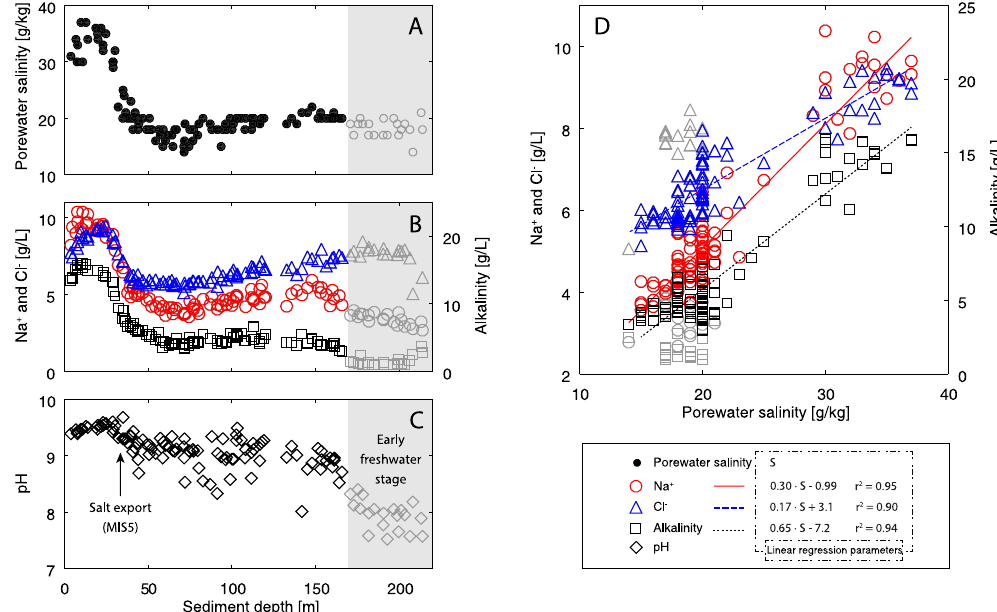
Figure 3. Salinity, Na + , Cl − , alkalinity, and pH profiles measured in the pore water of Lake Van. All measurements were conducted in the pore water of the same core-catcher samples used for the determination of salinity. The curves of the conservative species Na + (panel B, red circles) and Cl − (panel B, blue triangles), as well as that of alkalinity (panel B, black squares), mimic the shape of the salinity profile (panel A; see also Fig. 2). The linear correlations that exist between salinity and both Na + and Cl − (panel D, red circles/line and blue triangles/line) demonstrate that total salinity in Lake Van is virtually geochemically conservative and can thus be used as a conservative tracer for reconstructing lake levels. The linear correlation between salinity and alkalinity (panel D, black squares/line) indicates the presence of stable hydrochemical conditions over the time span relevant for the inferred lake-level changes. The gray symbols indicate measurements conducted in porewater samples with lower salinities that might represent a relict of Lake Van's earlier, freshwater, stage 15, 22 ; these measurements were therefore excluded from the calculation of the least squares regressions in panel D. The mean pH value for the time span relevant for the lake-level reconstruction is 9.1 ± 0.3 (calculated using the data plotted as black circles in panel C). This rather constant pH again suggests that the composition of the dissolved species in the water body of Lake Van was rather stable. A slight drop in pH observed at 32 m (approximately 86 ka BP) coincides with a water outflow (“open condition”) exporting salt from the lake during MIS5. A major decrease in pH below 170 m (gray circles) seems to result from the entrapment of “paleowater” from the time when the basin of Lake Van was not yet closed and operated as a freshwater